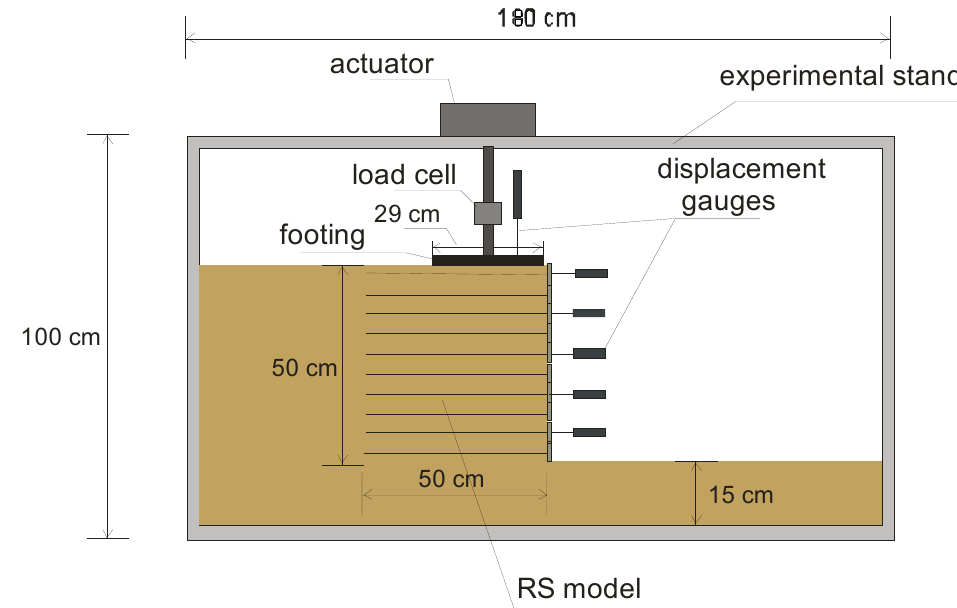
Figure 3. Cross-section of the experimental stand showing the positions of transducers.